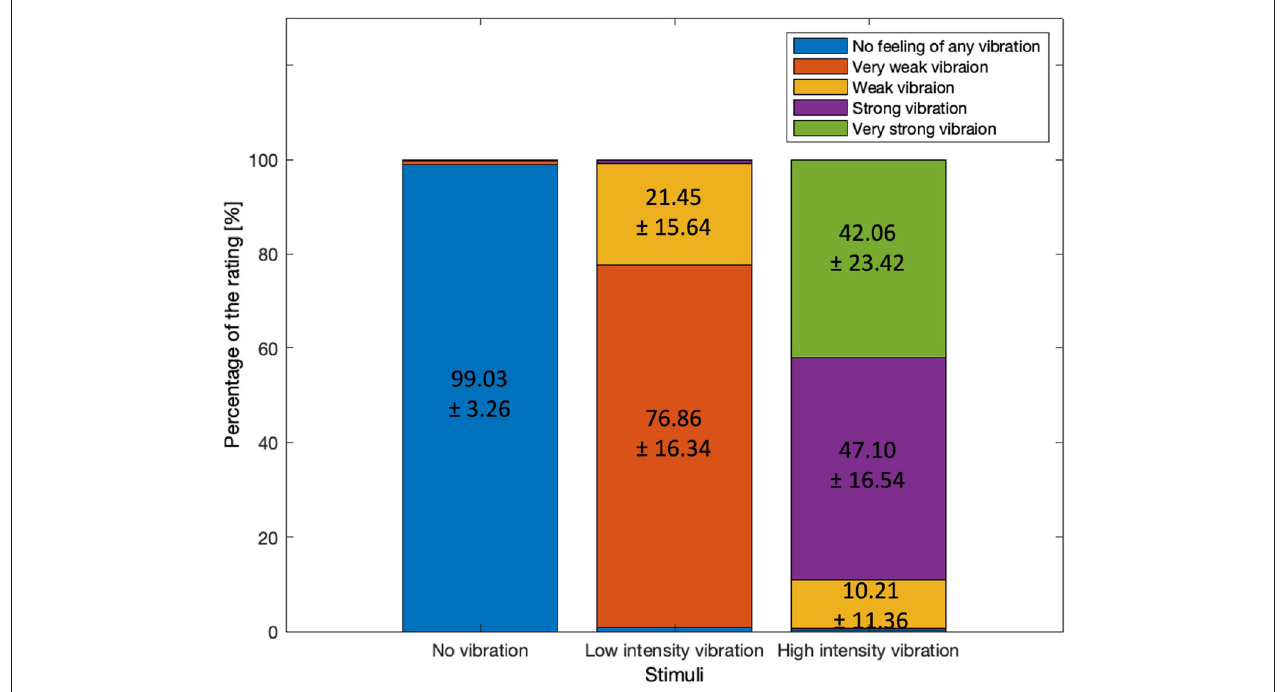
FIGURE 3 | The percentages of the rating by three different stimuli after the task period. Mean ± standard deviation among the participants.